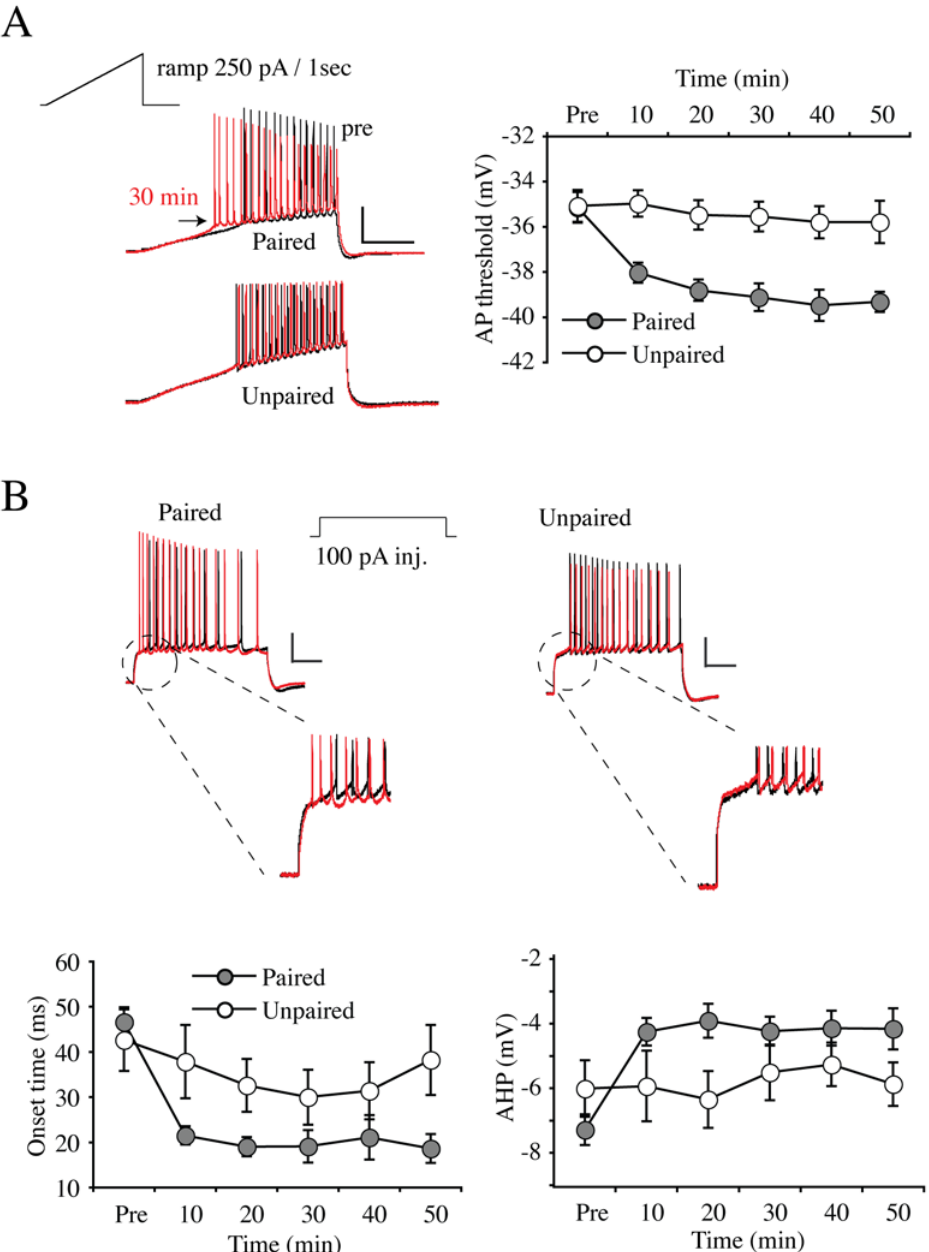
Figure 2. Synaptic potentiation reduces AP onset, threshold and AHPs. A . Current ramps (250 pA/s) were used to determine AP threshold. Examples of APs traces recorded before (black) and 30 min (red) after conditioning stimulation are given for paired and unpaired conditions. Scale bars: 40 mV, 200 ms. (right panel) Pooled data. The threshold to fire the first AP was lowered initially after LTP induction and this decrease persisted throughout the recording episode. B . Example traces upon + 100 pA current injection before (black) and 30 min (red) after conditioning stimulations. AP onset time and after-hyperpolarizing potential (AHP) were measured before and every 10 min after conditioning stimulation. Scale bars: 20 mV, 200 ms. (left lower panel) Pooled onset time data. Onset time was significantly decreased in paired neurons, while unpaired neurons did not show any significant decrease. As with AP threshold, the onset time changes occurred initially after LTP induction and persisted throughout the recording. (right lower panel) Pooled AHP data. AHP also persistently decreased only in paired neurons. Error bars represent